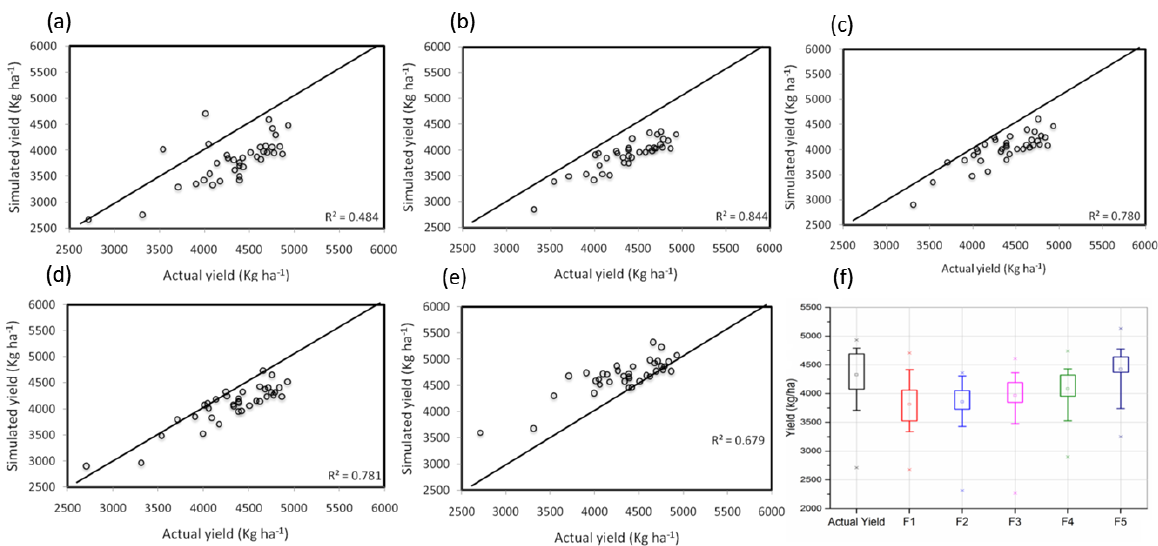
Figure 7. Statistical plots for yield simulations across the scenarios. ( a – e ) Correlation plots - actual yield vs. simulated yield for different scenarios F1, F2, F3, F4 and F5, respectively. ( f ) Box plots of yield across scenarios - the box represents the 25 to 75 percentile values; the whiskers represent the 10 to 90 percentile values; the cross hairs represent the minimum and maximum values for each simulation.